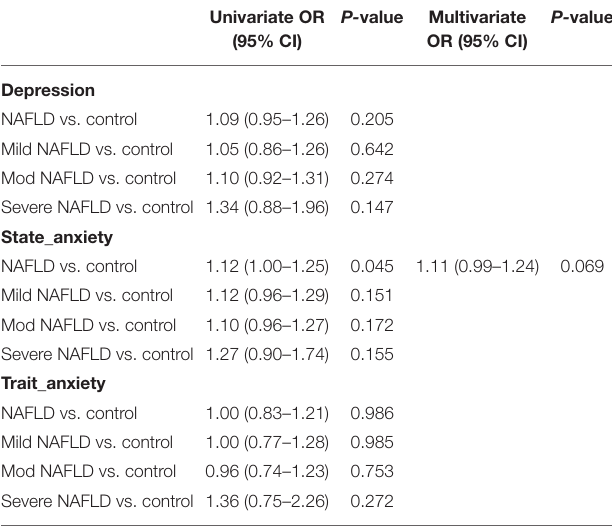
TABLE 3 | Univariate and multivariate analyses of the risk for depression or anxiety with vs. without NAFLD.